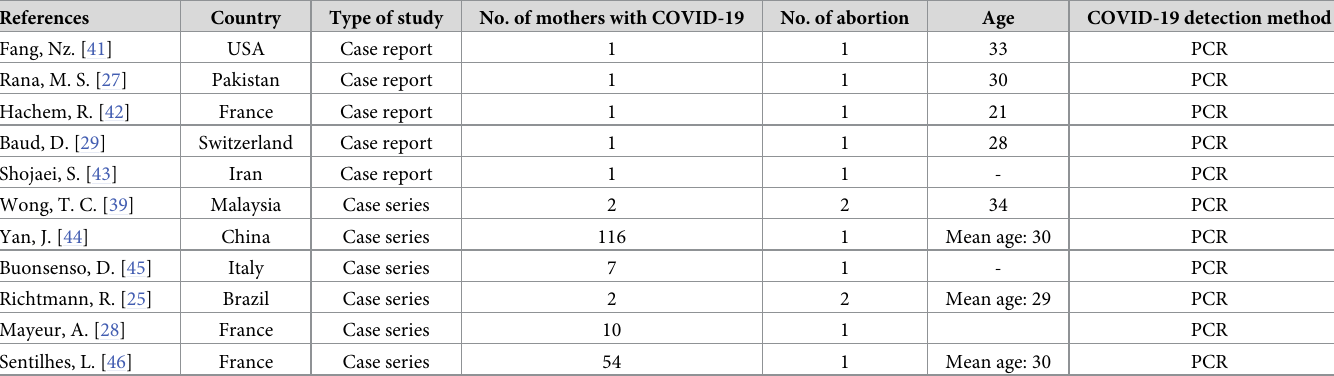
Table 1. Characteristics of the included studies.